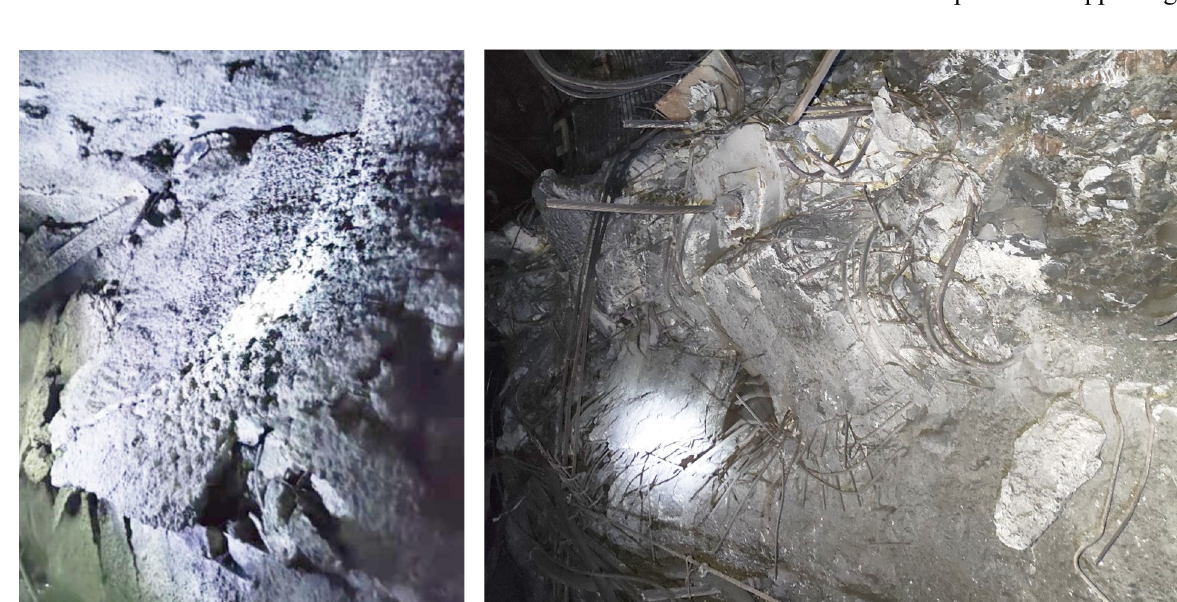
Figure 6. Previous supporting mode and roadway